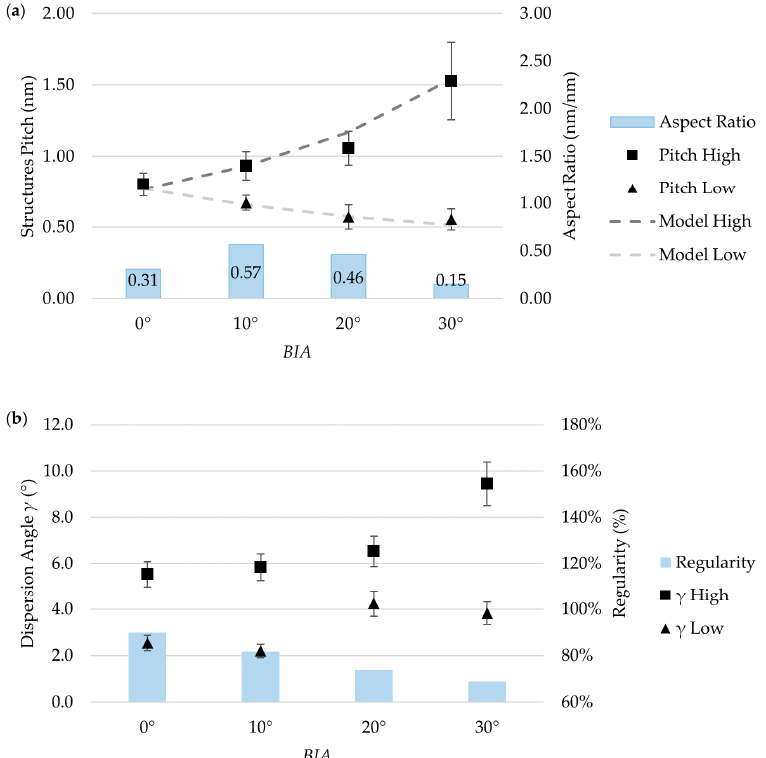
Figure 6. ( a ) Results of the AFM characterization of the four laser-machined steel mold inserts in terms of pitch and aspect ratio of the pattern; ( b ) plot of the pattern homogeneity study results for the four mold inserts.